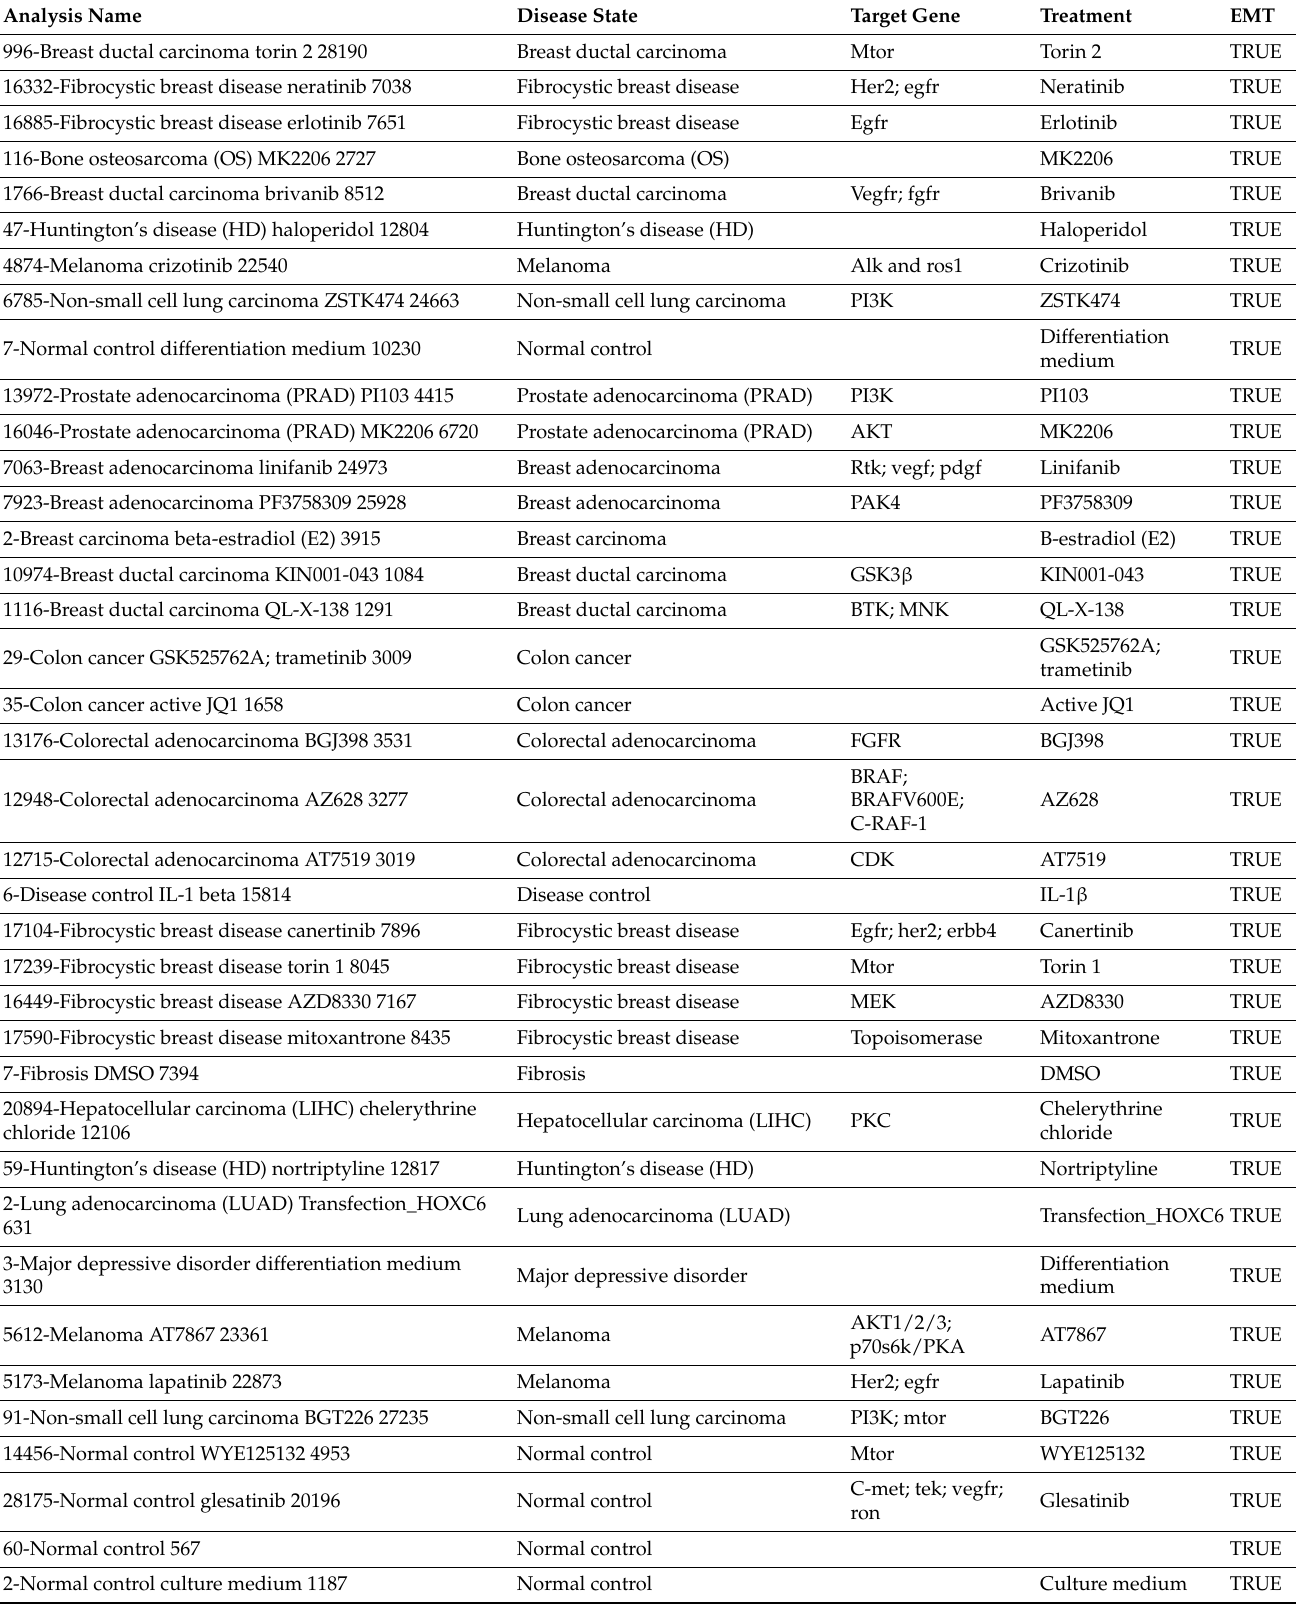
Table 1. Analyses in the regulation of EMT in the development pathway for AI prediction